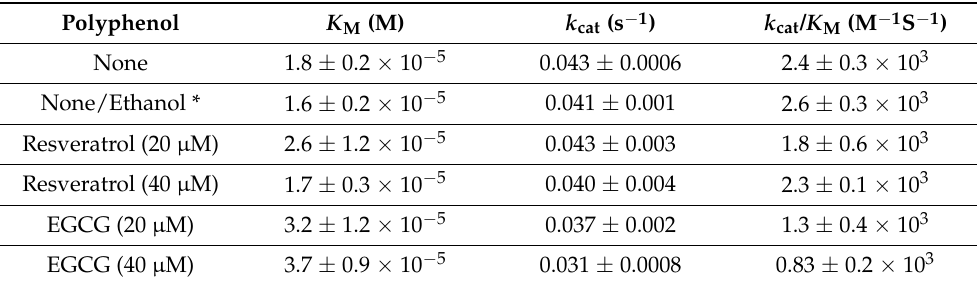
Figure 6. Kinetics of IDE-dependent degradation of insulin in the absence and presence of polyphenols at 37 °C. ( a ) Michaelis–Menten plots for insulin digests in the absence and presence of resveratrol were similar to one another, indicating that the polyphenol has no effect on IDE’s activity toward insulin. ( b ) Corresponding plots for the digestions in the absence and presence of EGCG clearly show that IDE’s activity decreased as the concentration of EGCG increased. Plots for polyphenol concentrations of 0, 20, and 40 μ M are shown in green, red, and blue, respectively. Each data point represents the mean from three trials. The solid lines are fits to the Michaelis–Menten equation. Table 1. Steady-state kinetic parameters for the IDE-dependent proteolysis of insulin determined from Michaelis–Menten plots.